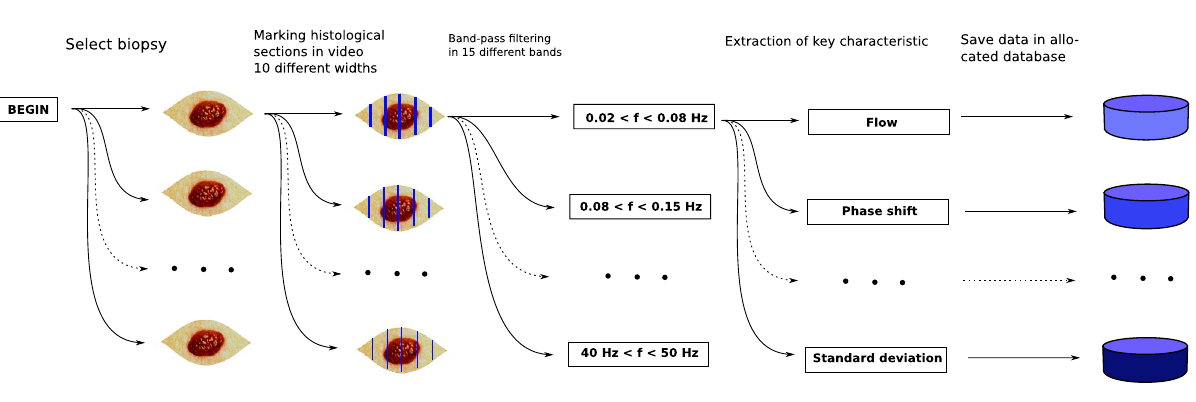
Figure 3. Diagram showing the acquisition of histological data in form of depth, width and area of the cancer tissue for each section cut for each biopsy.